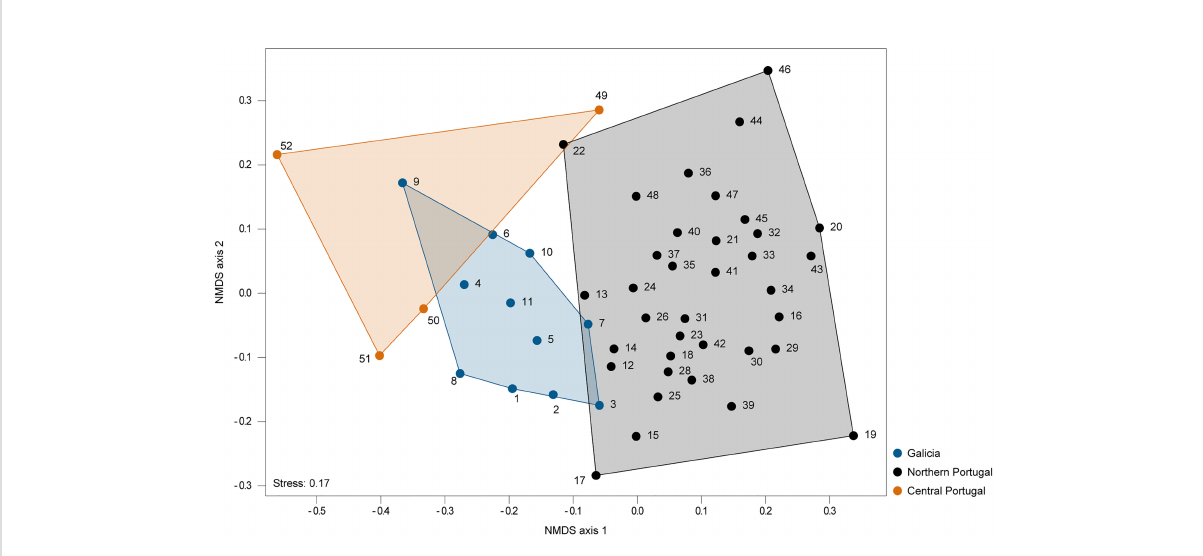
FIGURE 3 NMDS ordination plot of all sites based on the Bray-Curtis dissimilarity index. Blue symbols and blue polygon correspond to sites in Galicia, black symbols and black polygon correspond to sites in northern Portugal and orange symbols and orange polygon correspond to sites in central Portugal. Locations are depicted by an ID number, for more details see Supplementary Table 2